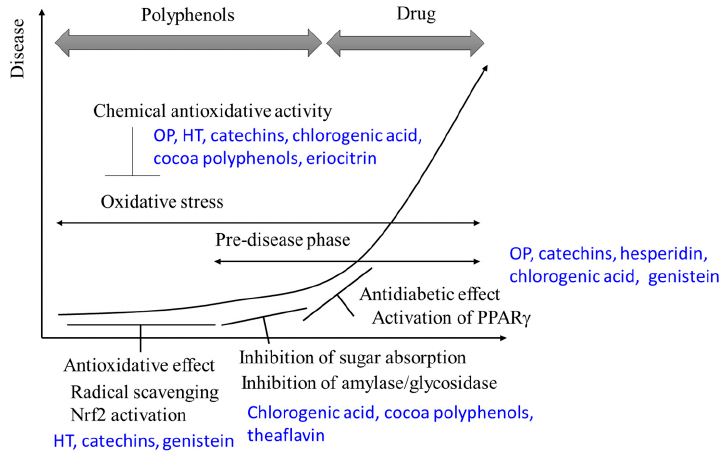
Figure 2. The preventative effect of polyphenol at each stage of diabetes.